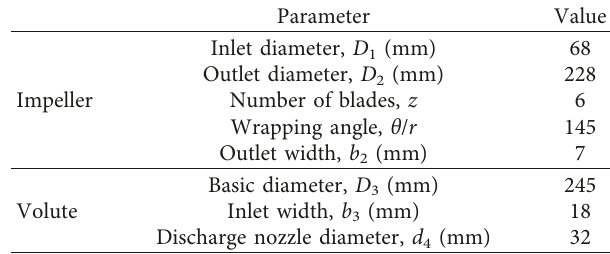
Table 1: Main geometry parameters of model pump.